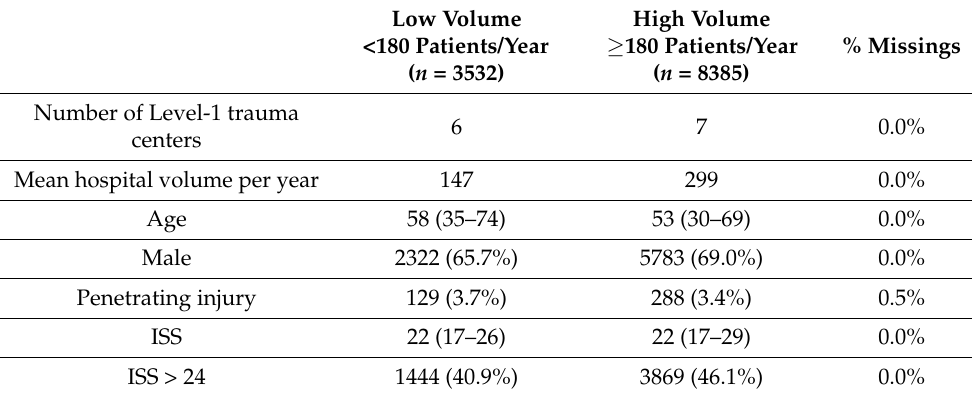
Table 1. Baseline characteristics divided by low and high hospital